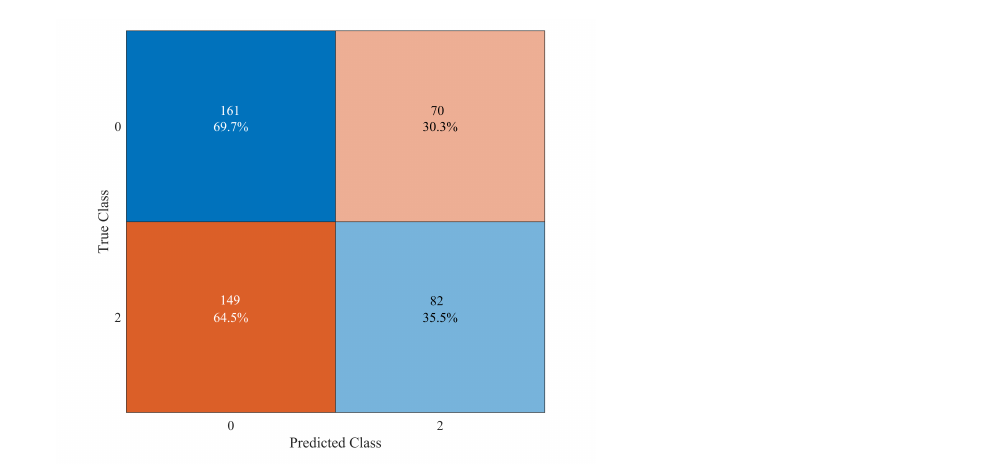
Figure 9. Confusion matrix for the binary classification between undamaged system (class “0”) and “Elm 4115” damaged (class “2”).